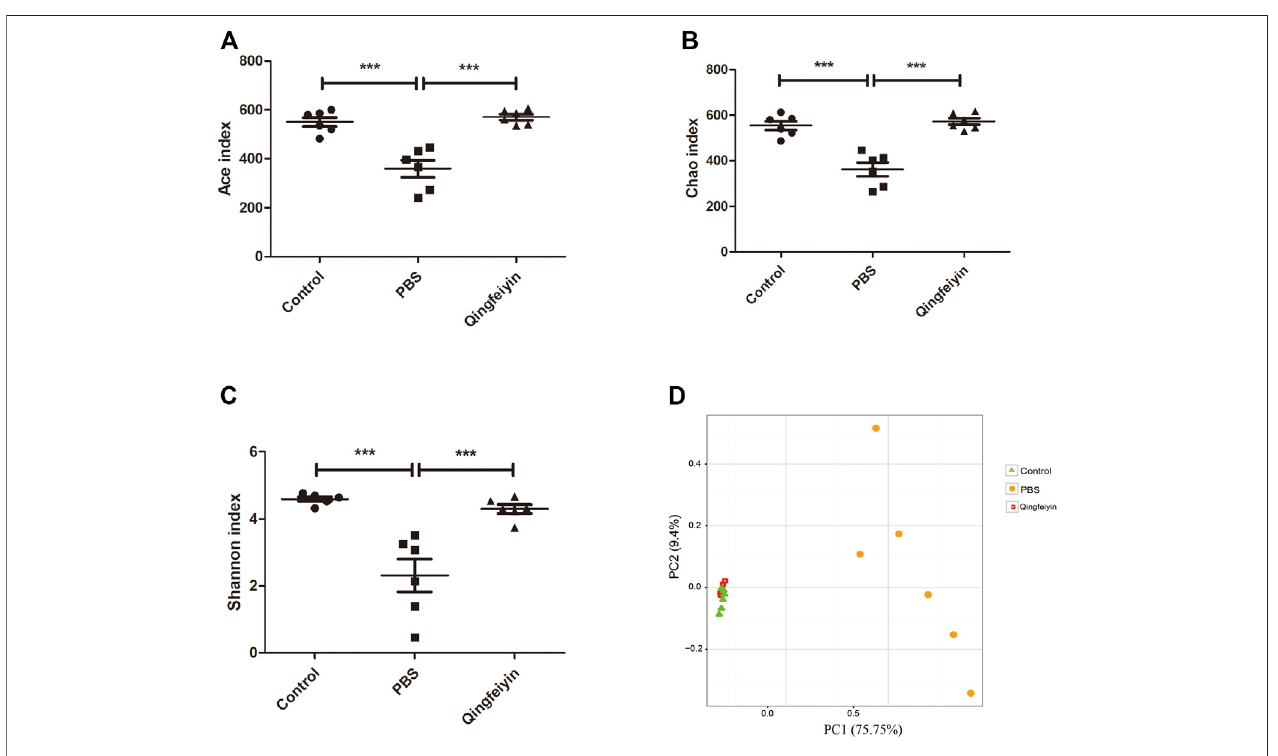
FIGURE 6 | α and β diversity of cecum content. (A – C) , represents Ace, Chao, and Shannon indexes, respectively. (D) represents the plot of principal component analysis (PCA). The data (A – C) were analyzed using one-way ANOVA followed by Tukey ’ s test ( p < 0.05). The data of D were analyzed using nonparametric MANOVA based on Adonis. *** p <